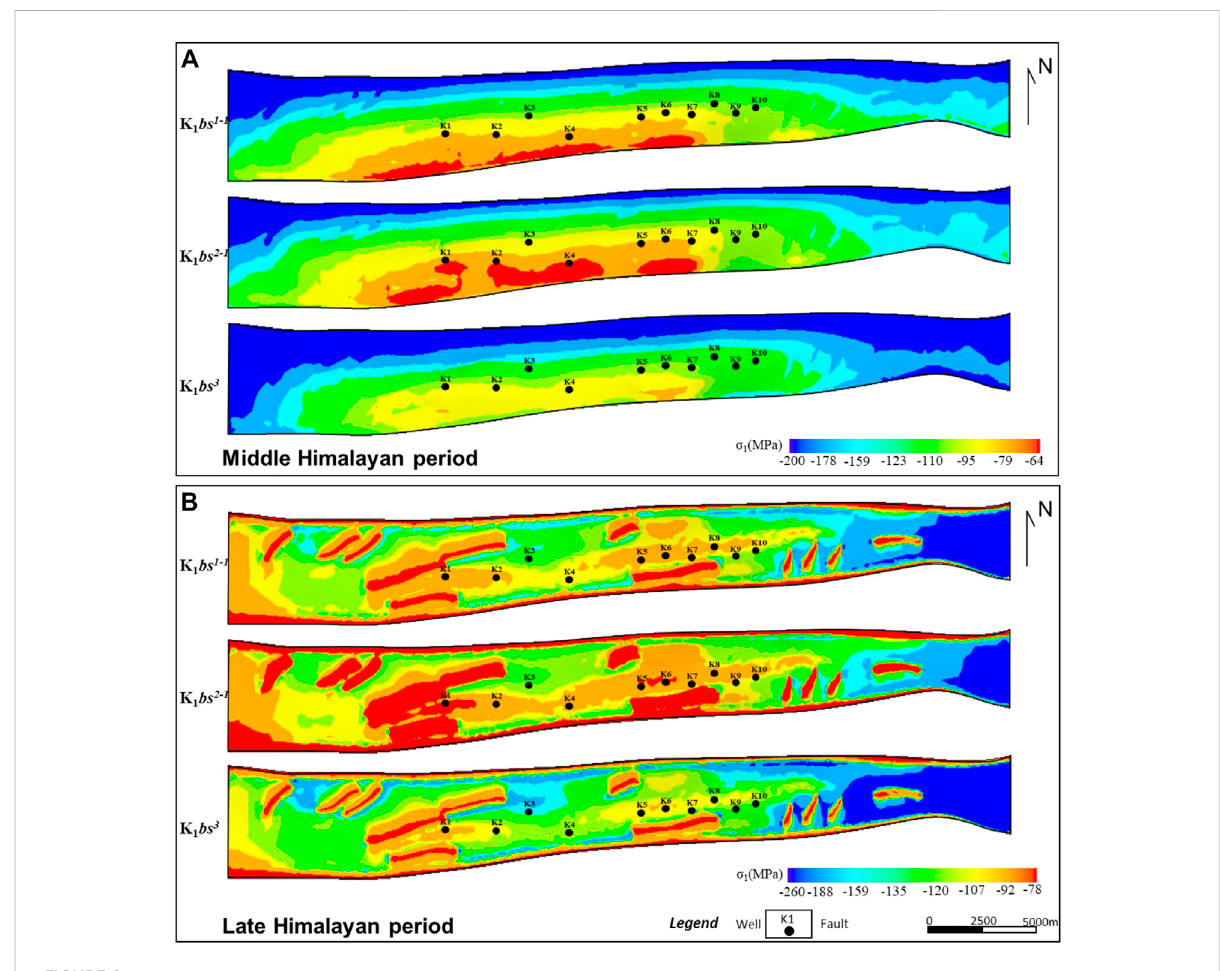
FIGURE 9 Distribution of paleo-tectonic stress fi eld in different period. (A) Maximum principal stress in middle Himalayan period of target layer; (B) Maximum principal stress in late Himalayan period of target